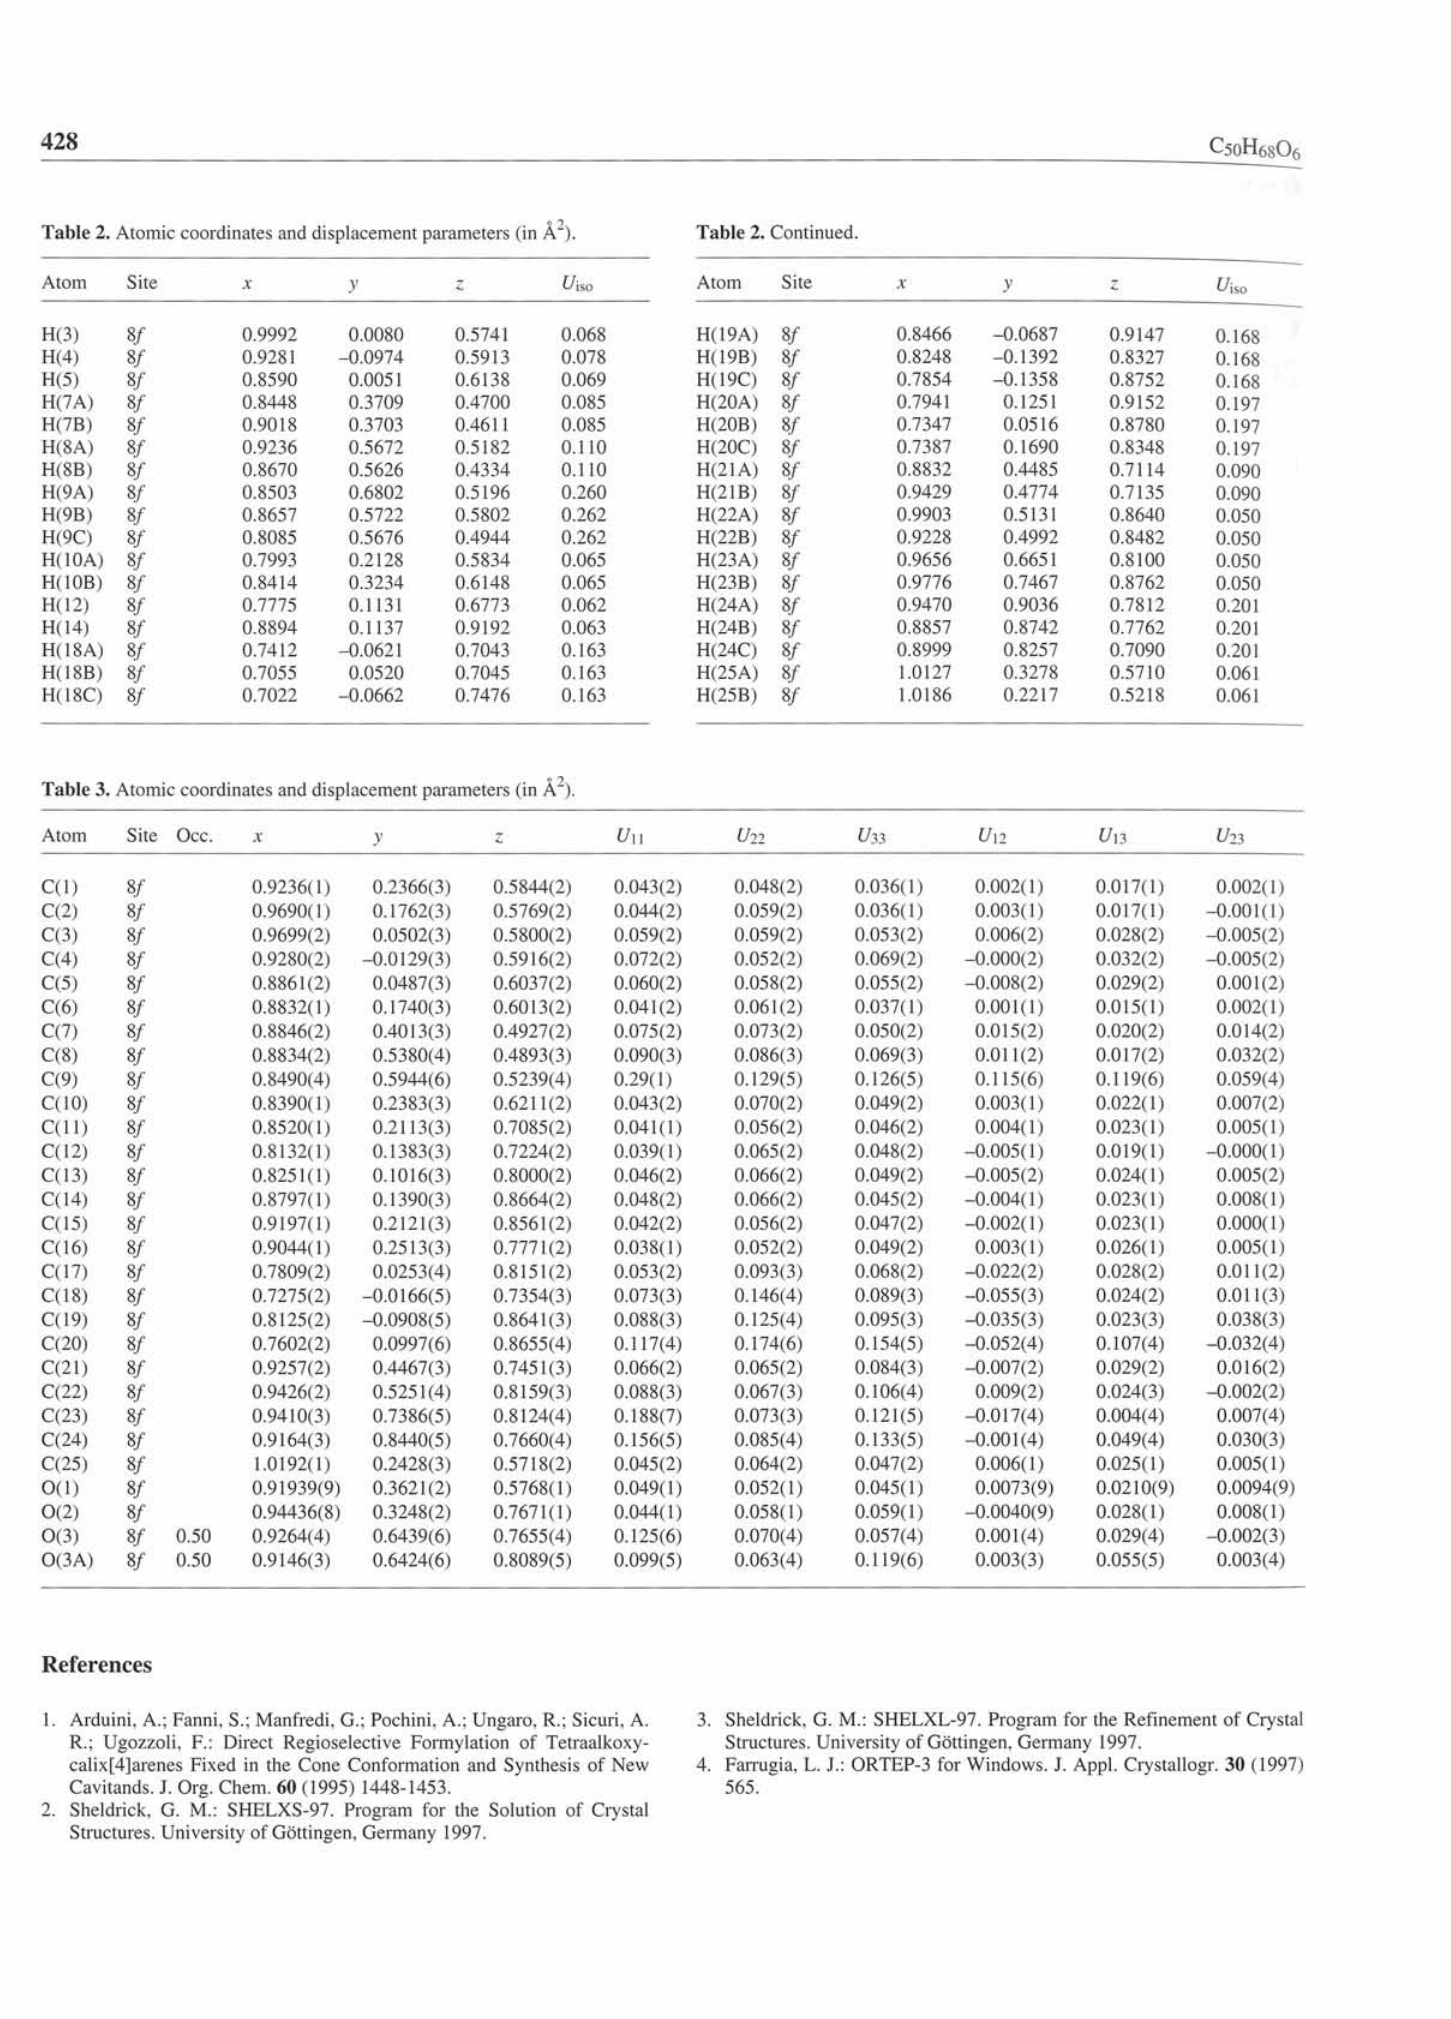
Table 3. Atomic coordinates and displacement parameters (in Â 2